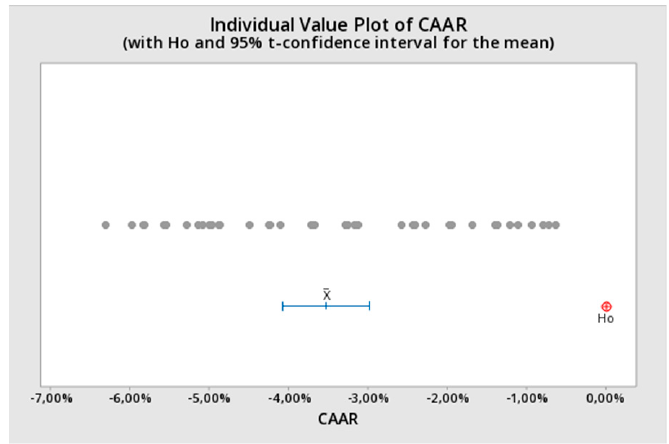
Figure 4. t -Test histogram of CAAR for E ( − 20,+20).